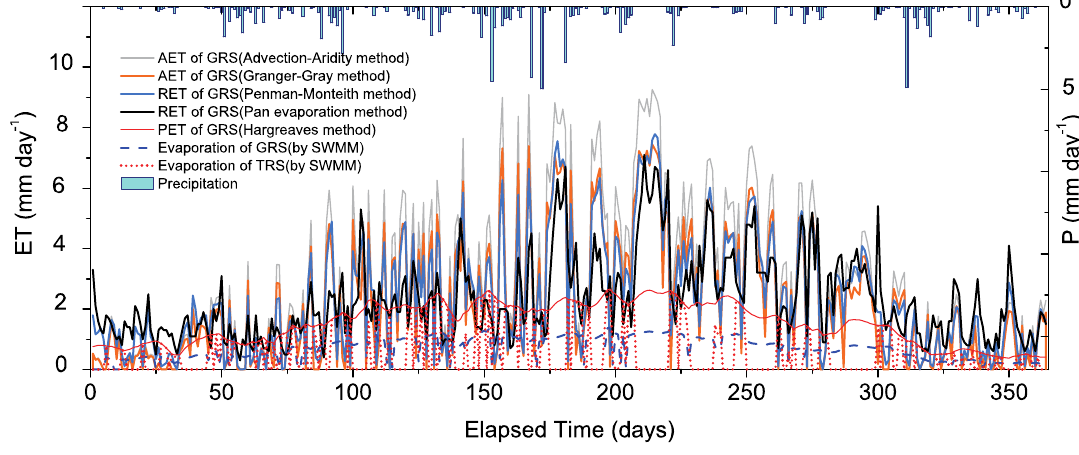
Figure 10. Daily mean GRS ET over 31 years (from Figure 9. Daily mean GRS ET over 31 years (from 1985-2015). 499